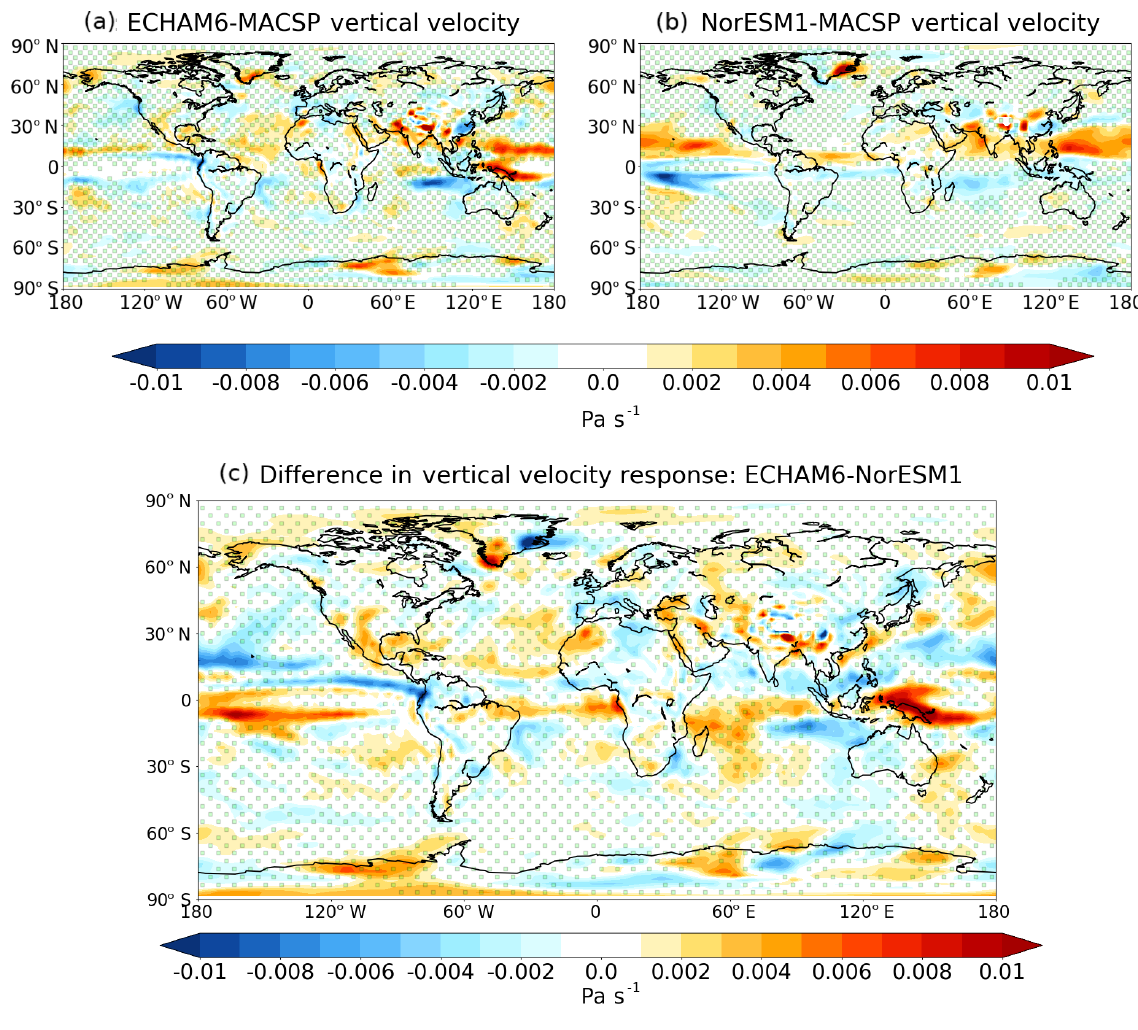
Figure C4. Vertical motion response at the 600hPa level to the ad- dition of anthropogenic aerosols. (a) Response in the ECHAM6- MACSP experiment; (b) response in the NorESM1-MACSP ex- periment; (c) the difference in responses between the experiments. The green dots represent the area where anthropogenic aerosols do not have a statistically significant impact at the p < 0 . 05 level (in panel c ) or where the difference between the models is not statisti- cally significant (in panels a and b